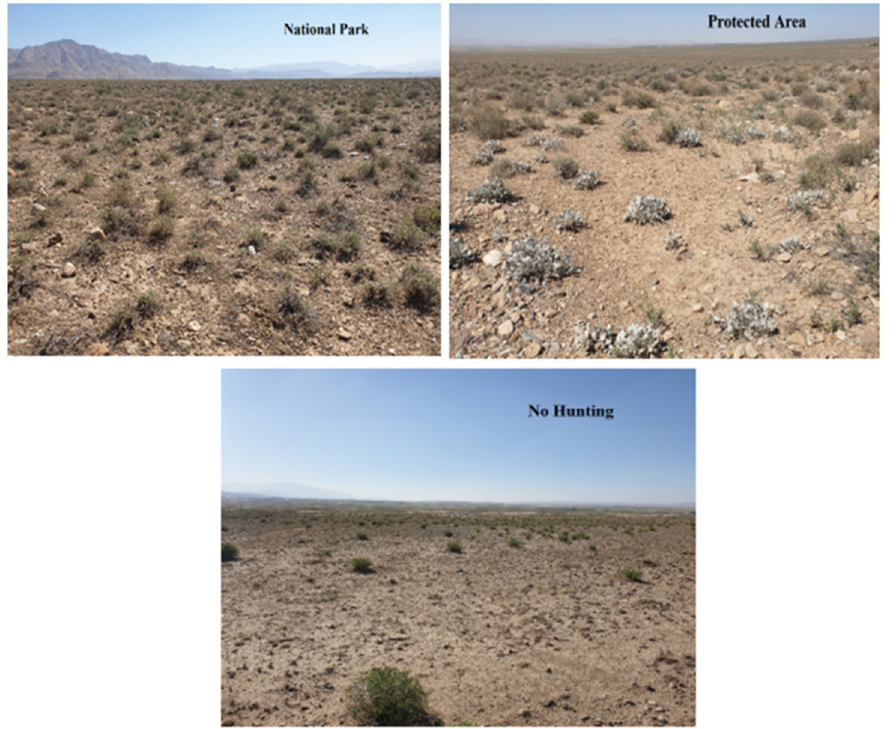
Figure 2. The views of the study area.